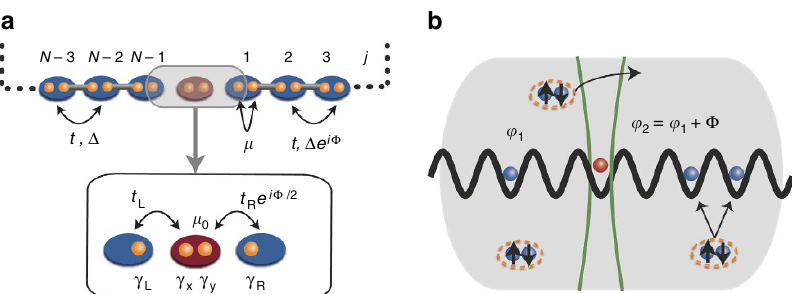
Figure 1 | System Hamiltonian and cold atom setting. ( a ) Schematics of the model Hamiltonian equation (1): the central part of the system is magnified in the box at the bottom, where the Majorana degrees of freedom included in the simplified model (equation (2)) are highlighted. ( b ) Implementation in a cold atom system. A 1D optical lattice is coupled to a BEC reservoir that gives rise to the Kitaev Hamiltonian in the chain. An optical barrier acts both to create the impurity site (red) and triggers the Josephson effect in the reservoir itself. The phase difference across the barrier in the reservoir then acts as the phase F for the optical